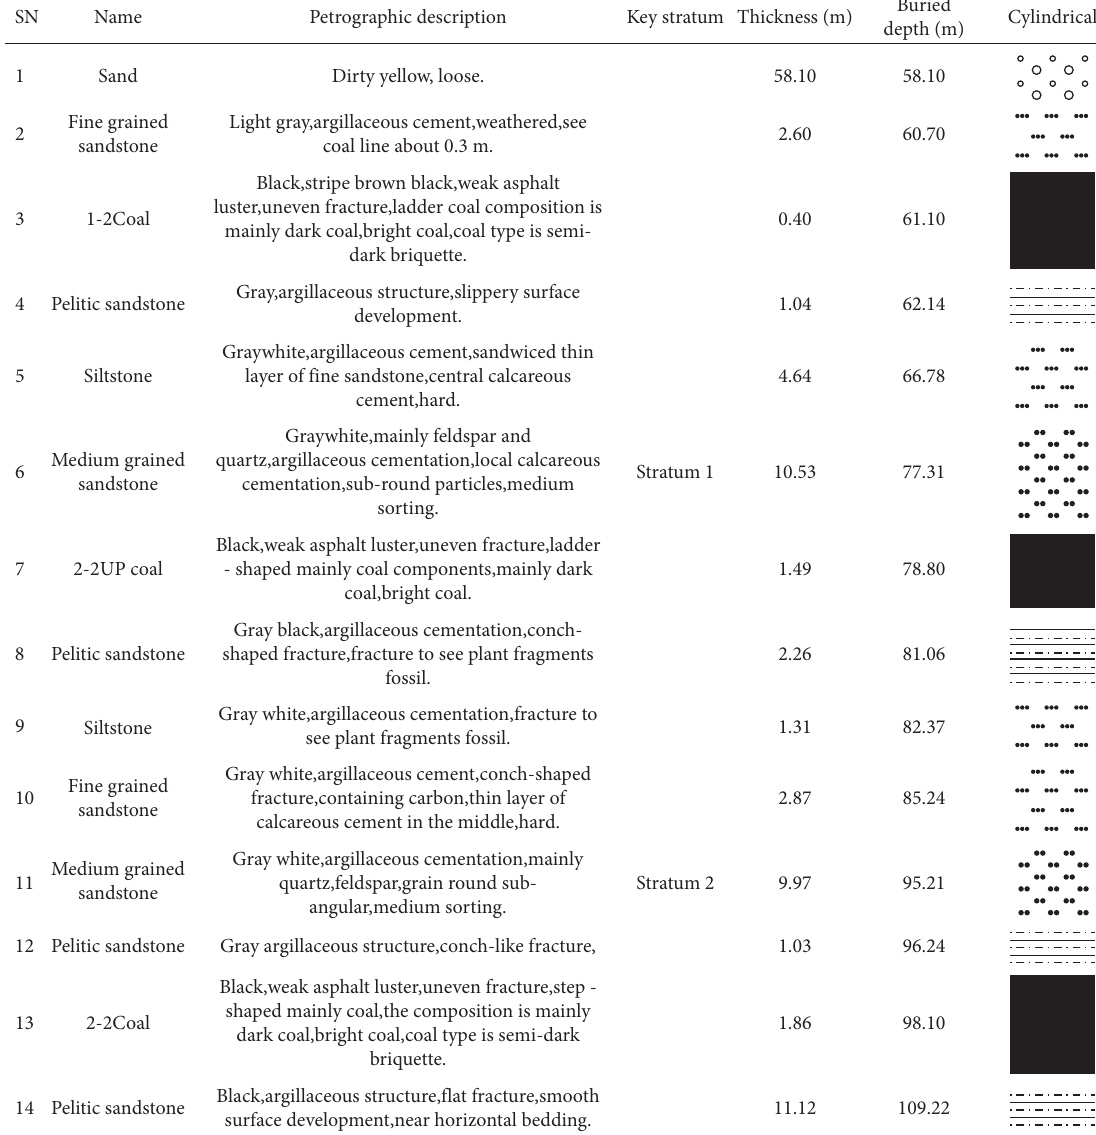
Figure 1: Borehole histogram of the 22306 working face in the Shigetai